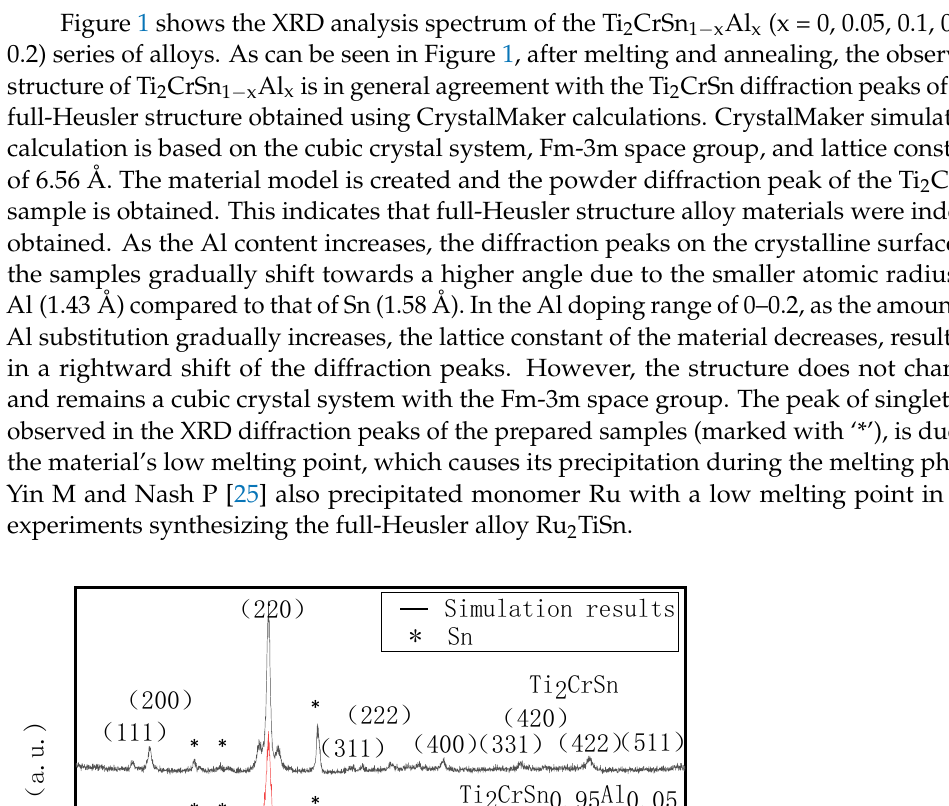
2 CrSn 1 − x Alx (x = 0, 0.05, 0.1, 0.15, 0.2)